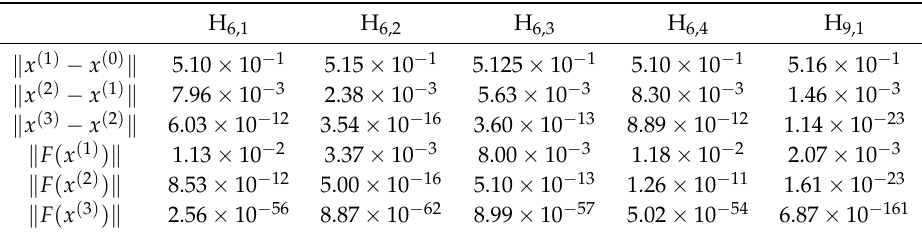
Table 5. Numerical results for Example